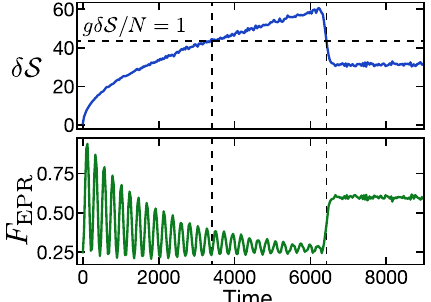
FIG. 3. Probing operator size width in a 1D RUC. Top: The size width initially grows as t 1 = 2 and reaches a peak at the scrambling time t (cid:2) ∼ N ¼ 10000 . Bottom: We probe this behavior by measuring the teleportation fidelity of a single qubit with a large ffiffiffiffi p N coupling g ¼ 57 π ∼ . The fidelity exhibits a distinct decay- revival profile, controlled by whether the size width exceeds the threshold g δ S =N ≈ 1 : nearly perfect fidelity initially, power-law decay toward a trivial fidelity at intermediate times, and partial revival at late